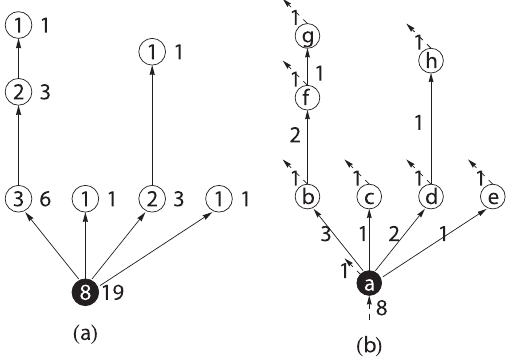
Figure 8. T i and C i for trees. In (a), the numbers inside the nodes are T i s and the numbers beside nodes are C i s. (b) is a flow network constructed according to (a), in which numbers represent flows. And dotted lines stand for dissipations.